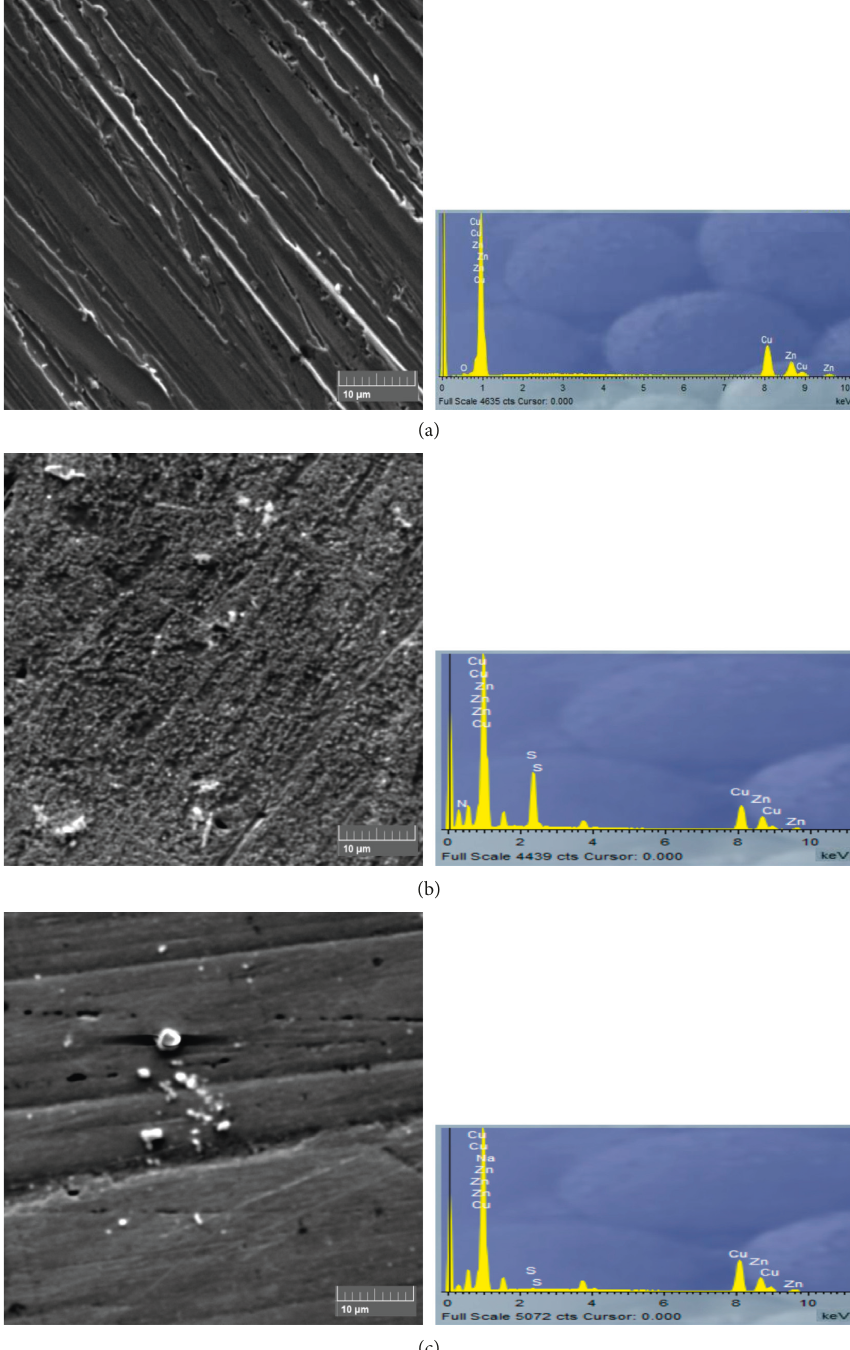
Figure 9: SEM and EDS analysis of (a) the polished brass surface without any treatment, (b) the brass surface after immersion of the electrode for 1140 min in 1 · 10 − 2 M cysteine solution, and (c) the brass surface after immersion of the electrode for 4080 min in 1 · 10 − 3 M SDS